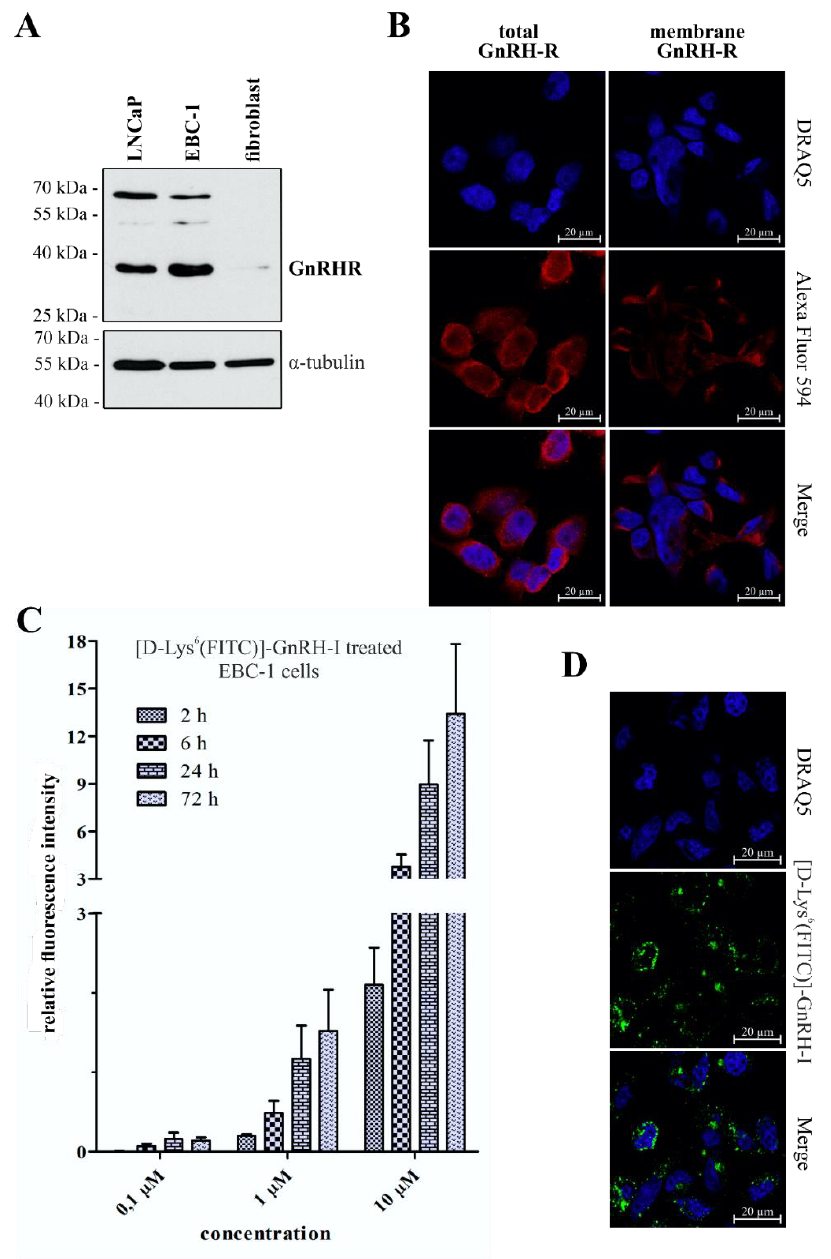
Figure 3. GnRHR expression and cellular uptake of [ D -Lys 6 (FITC)]–GnRH-I on EBC-1 cells. ( A ) Expression of GnRHR in EBC-1 cells, confirmed by western blot; ( B ) EBC-1 cells contain a high level of GnRHR (total GnRHR) and a high proportion of these receptors are located in the plasma membrane (membrane GnRHR). Nuclei: blue (DRAQ5), GnRHR: red (Alexa Fluor 594); ( C ) Time- and concentration-dependent dynamic uptake of [ D -Lys 6 (FITC)]–GnRH-I was confirmed by flow cytometry. Results are presented as mean relative fluorescent intensity ± SD ( N = 3); ( D ) Intracellular localization of [ D -Lys 6 (FITC)]–GnRH-I (green; 10 µM, 24 h) in EBC-1 cells was confirmed by confocal microscopy (nuclei: blue).